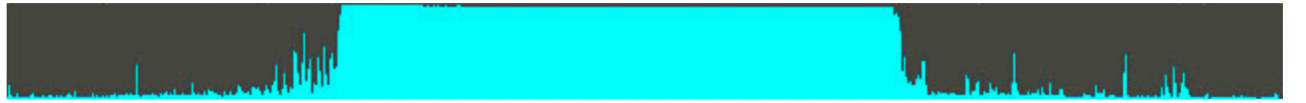
Figure 10. The measured intensity of one profile on a shiny smooth surface. Points in the laser line are no longer detected on the left and right side because of low laser